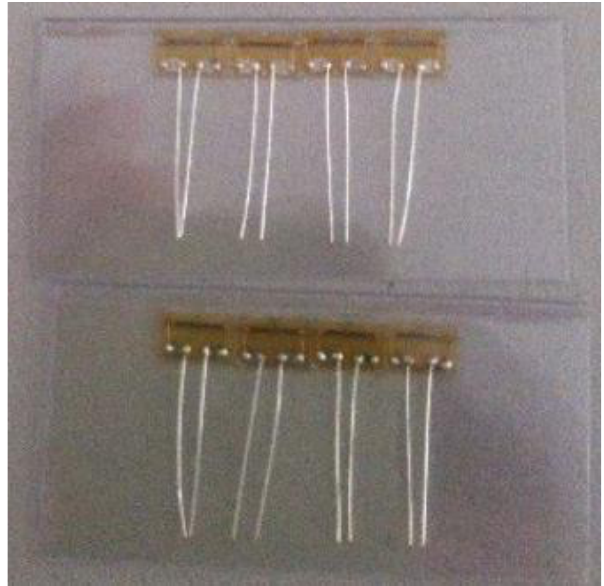
Figure 9. Semiconductor strain gauge.